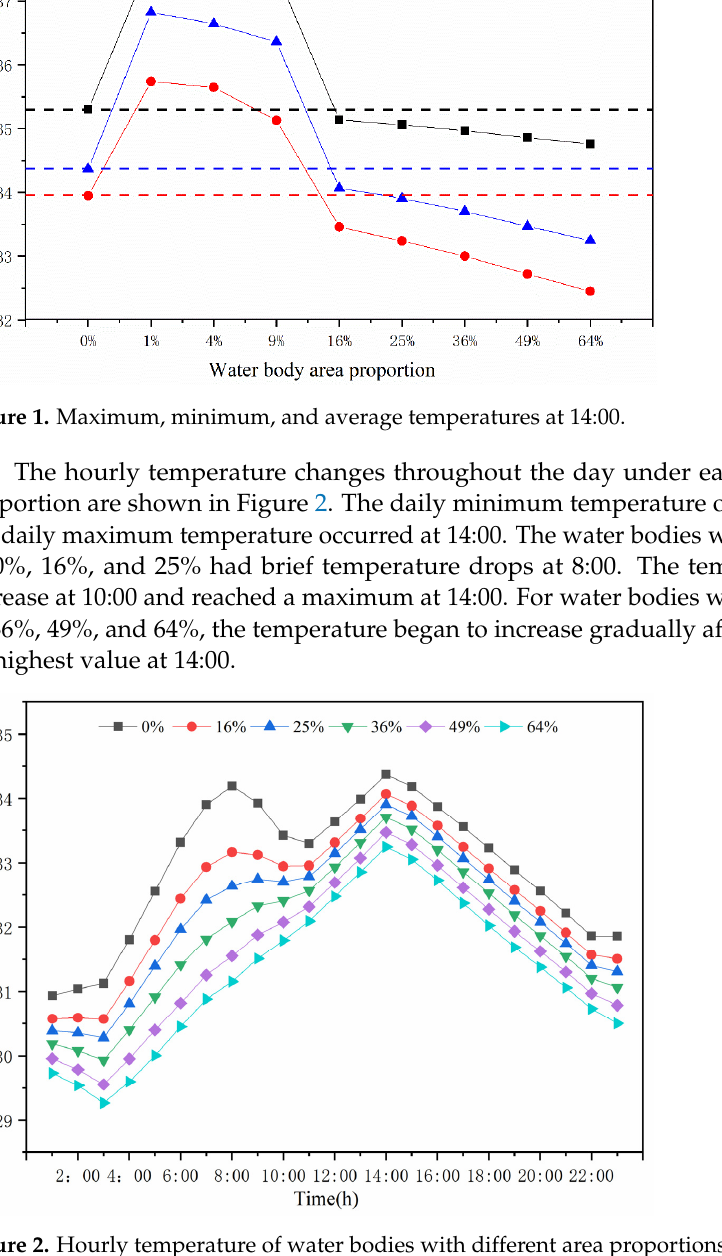
Figure 2. Hourly temperature of water bodies with different area proportions throughout the day.